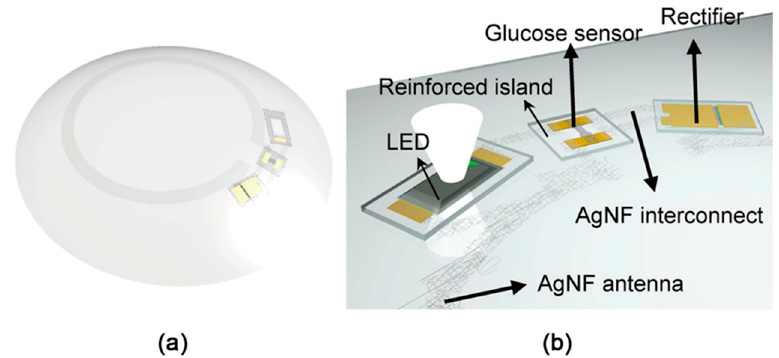
Figure 8. Schematic illustration of the smart contact lens. The contact lens consists of the soft base—hybrid substrate, which is made of photocurable optical polymer with micropatterned Cu layer and silicone elastomere (elastofilcon A). The functional devices integrated in the base are: a rectifier, LED, a glucose sensor and a transparent, stretchable conductor for antenna and interconnects, made of Ag nanofibers (AgNF). Adopted with permission from [135]. Copyright 2018, American Association for the Advancement of Science.